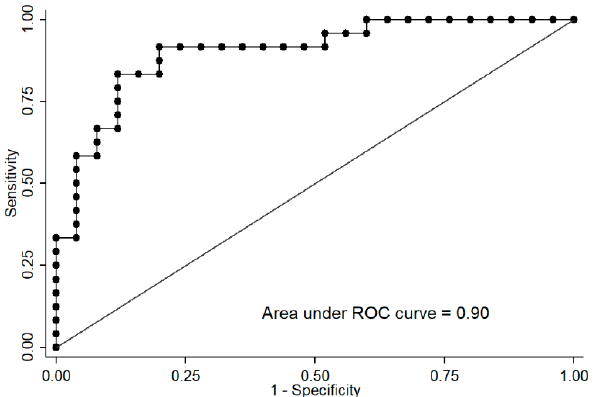
Figure 5. Receiver operating characteristic ( ROC) curve of the logistic regression of cg04615668- CTNND2 and cg07263235- LPL adjusted by sex allows the discrimination of subjects with the calculated insulin sensitivity index (CSi) ≤ 5.7 (insulin-resistant) versus >5.7 (insulin-sensitive).